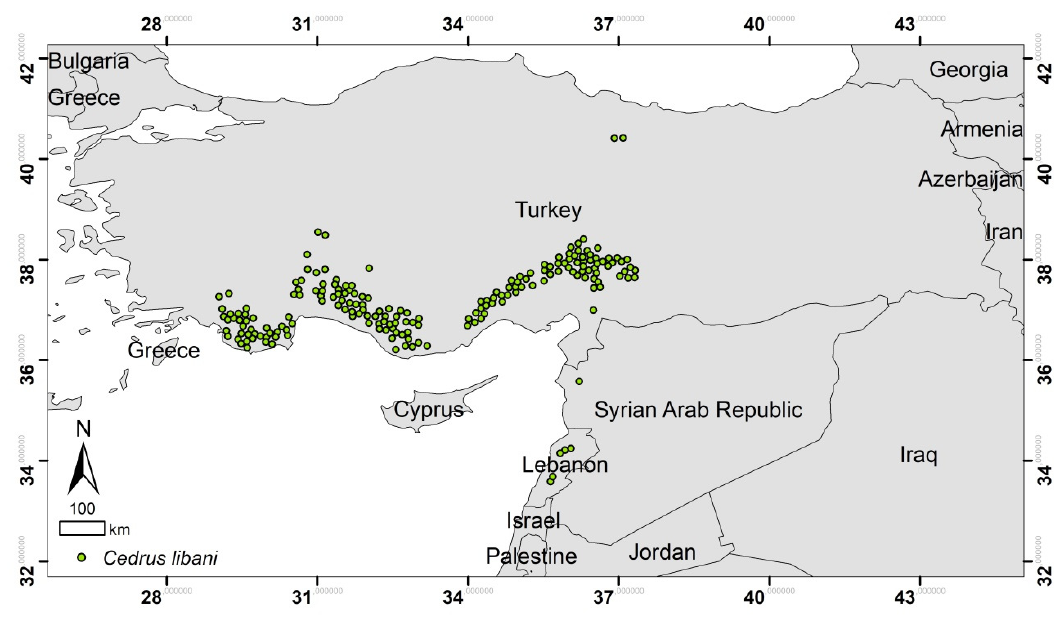
Figure 1. The map of the study area and species occurrence data.